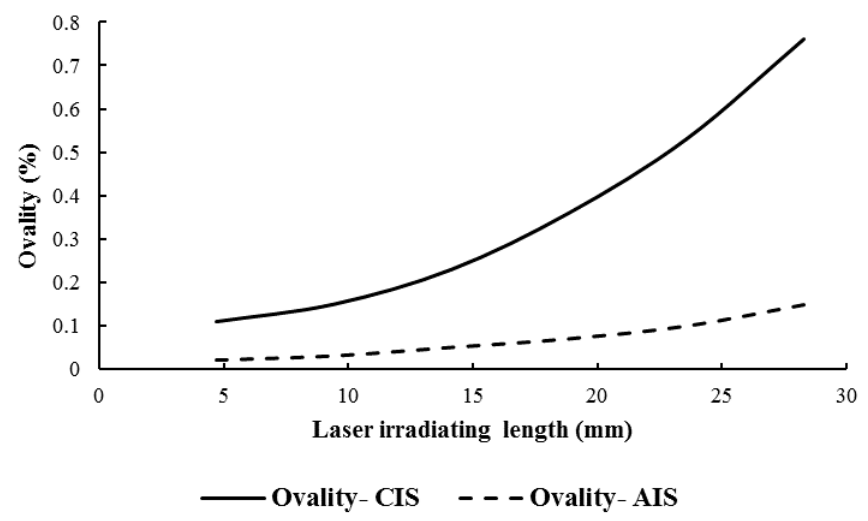
Figure 6. The effect of irradiating schemes on the ovality percentage of laser-bent tubes.